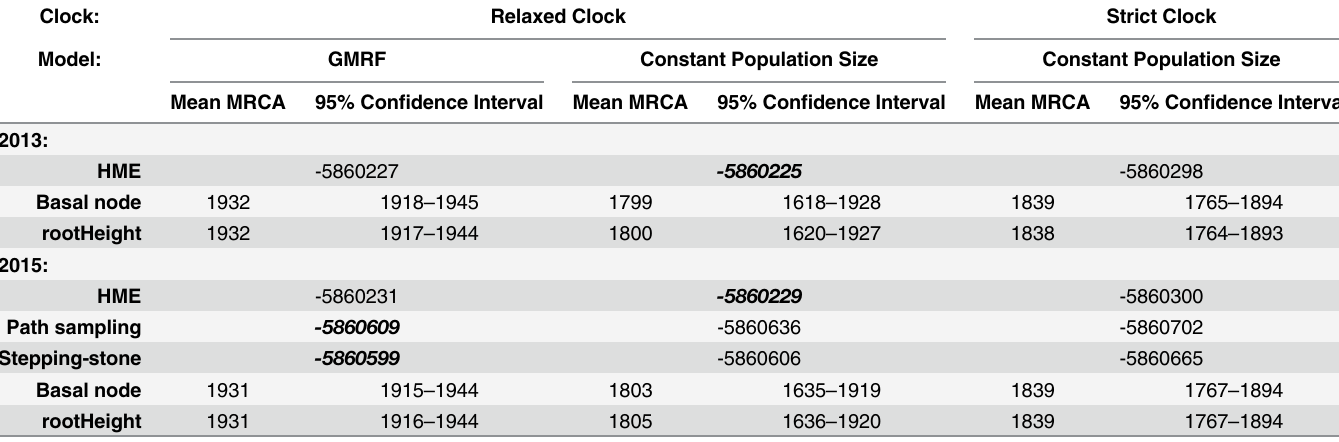
Table 1. Age estimates and Bayes Factors from BEAST analyses of 864 non-repetitive, non-recombinant, non-homoplastic core SNPs from 73 eBG54 (Agona) genomes.